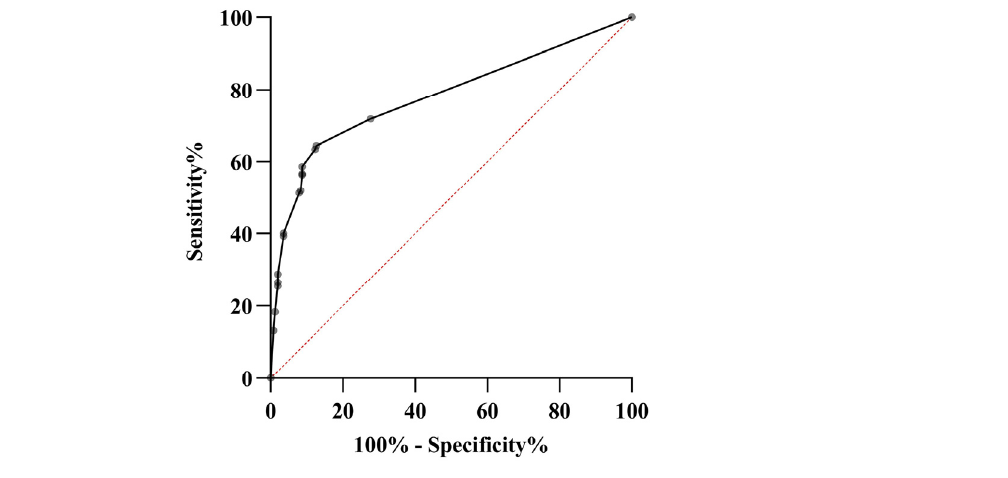
Figure 5. ROC curve of the screening score for CHIKV infection. ROC: Receiver operating characteristic; CHIKV: Chikungunya virus.